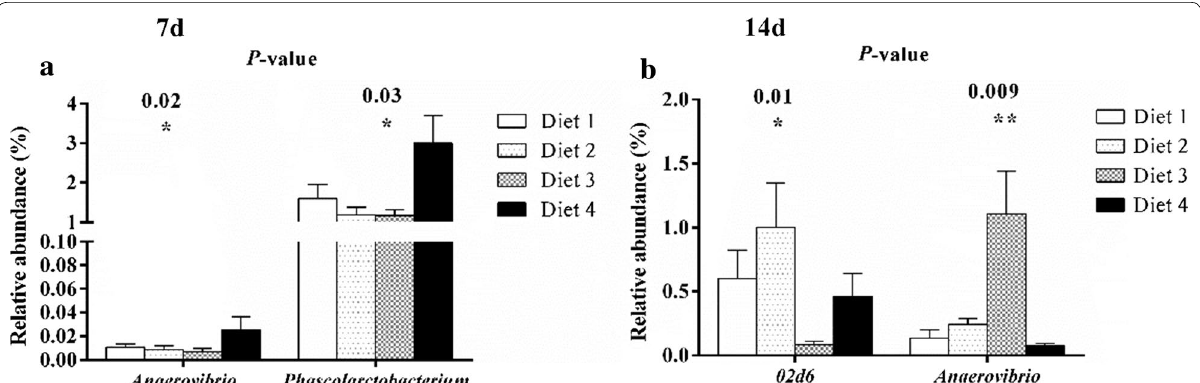
Fig. 7 The bacterial abundance of genera significantly differs in different phases. Only the data whose differences with P -values are lower than 0.05 are shown. 7 d ( a ) and 14 d ( b ) represent experimental day 7 and 14, respectively. The relative abundance at genus level was statistically analyzed through non-parametric Kruskal–Wallis tests. * P < 0.05, ** P <